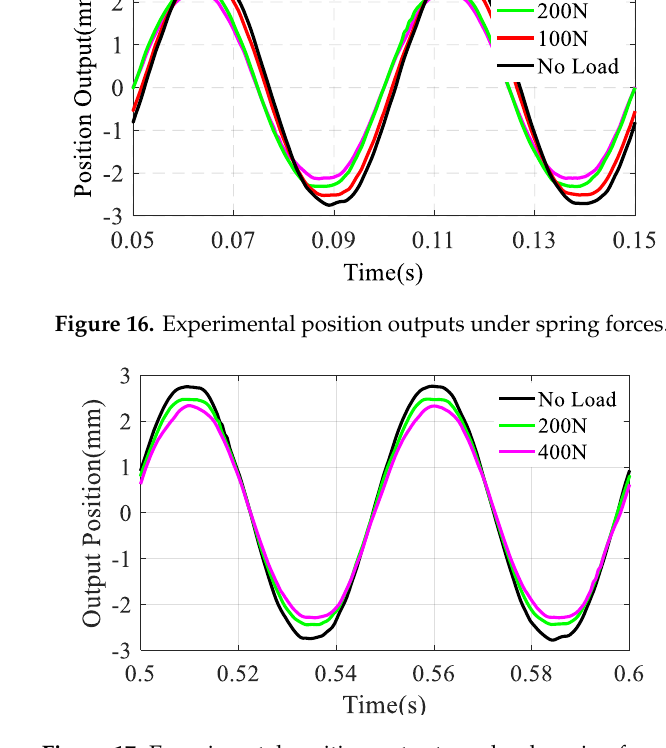
Figure 17. Experimental position outputs under damping forces.